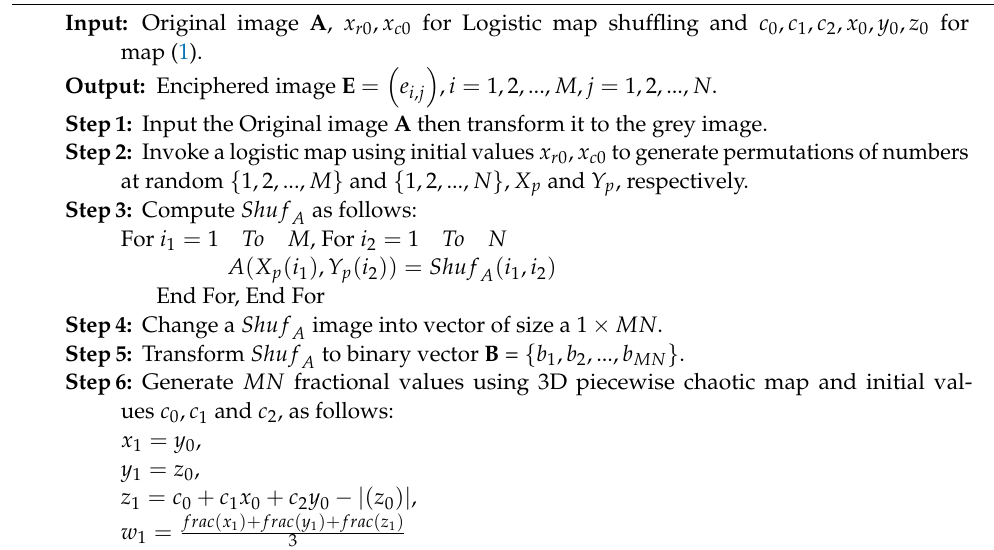
Algorithm 1 Encipherment Algorithm